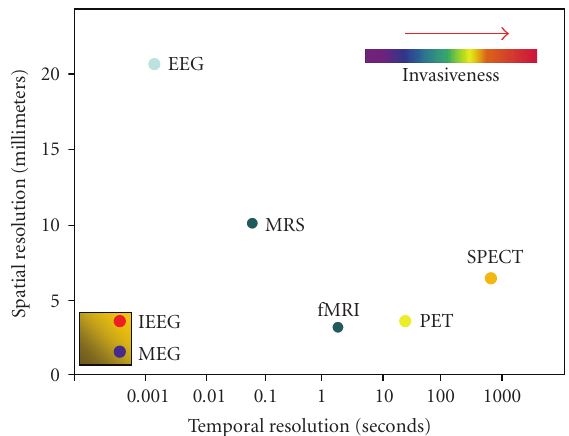
Figure 1: Graphic showing the relative spatial and temporal re- solutions of common neuroimaging techniques (EEG: Electro- encephalography, IEEG: Invasive Electroencephalography, MEG: Magnetoencephalography, MRS: Magnetic Resonance Spectrosco- py, fMRI: functional MRI, SPECT: Single Photon Emission Cranial Tomography, and PET: Positron Emission